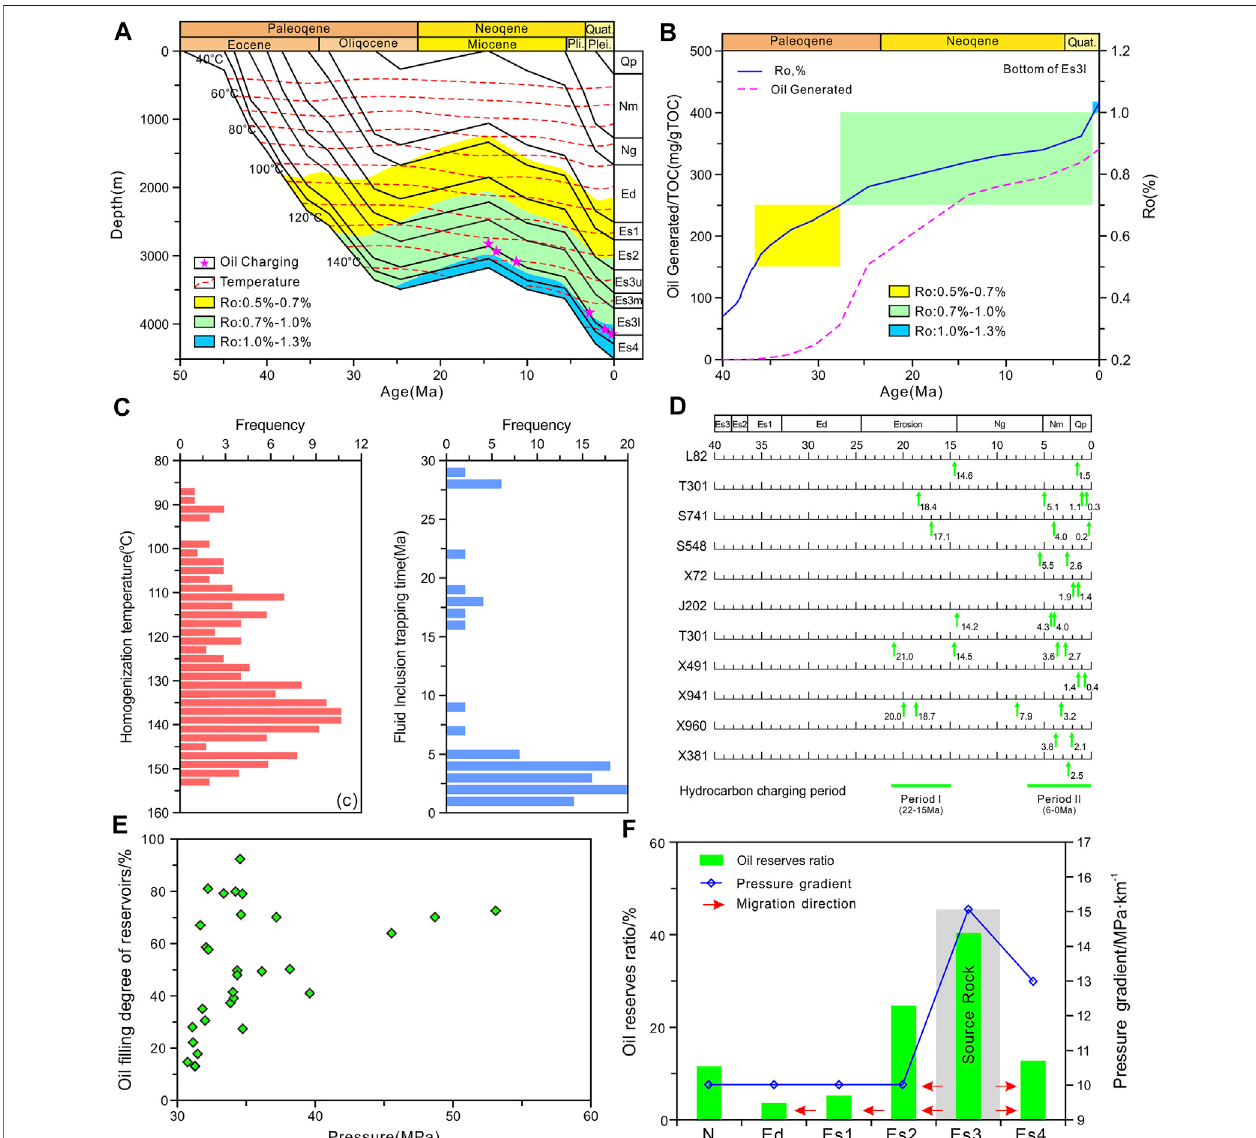
FIGURE 14 | Hydrocarbon generation and expulsion of the Linnan Sag. (A) Maturation and burial history of X99. (B) History of oil generation from theEs3l source rock (Es3l). (C) The homogenization temperature and trapping time of fl uid inclusions. (D) Hydrocarbon accumulation stages and charging periods ofwells in the Linnan Sag. (E) The relationship between pore pressure and oil fi lling degree of reservoirs. (F) The relationship between overpressure and oil reserves ratio of the Linnan Sag (modi fi ed from Jiang et al. (2016)).